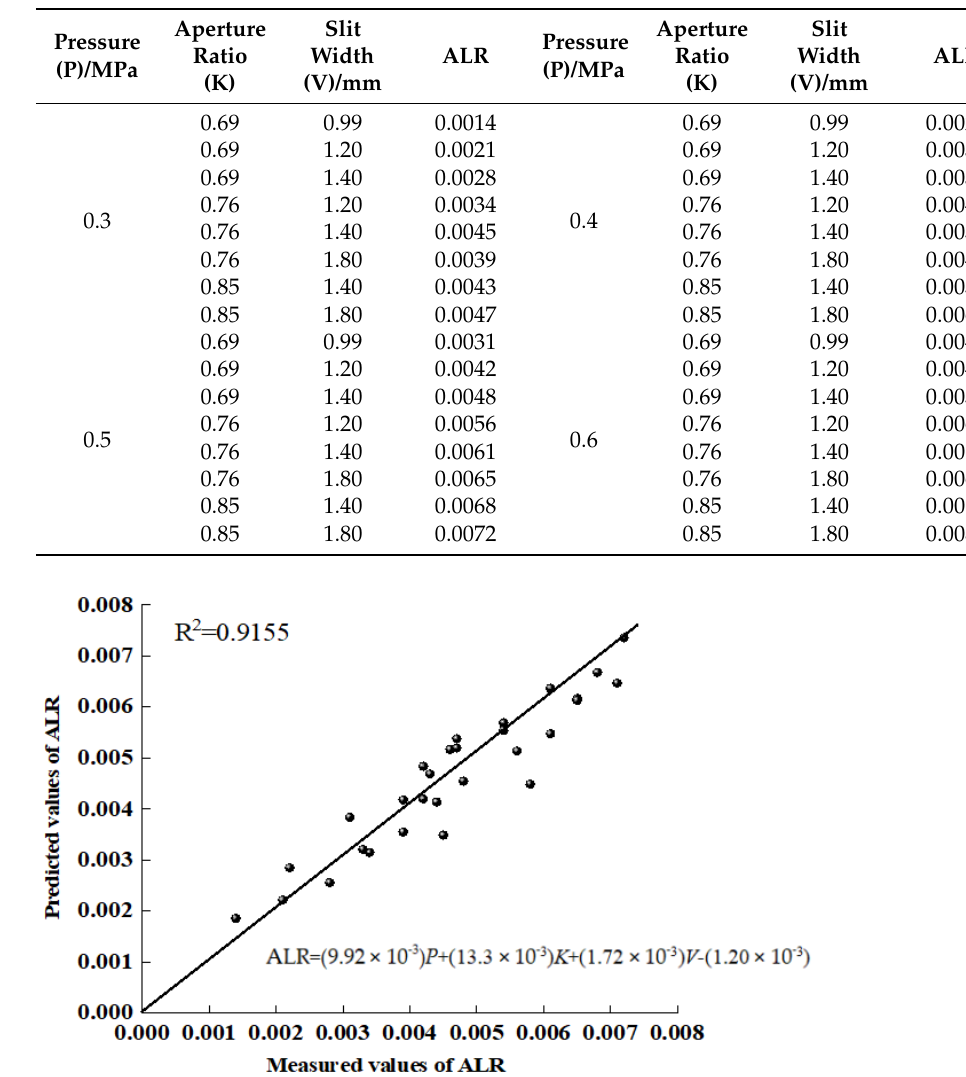
Table 3. Test protocols and results.